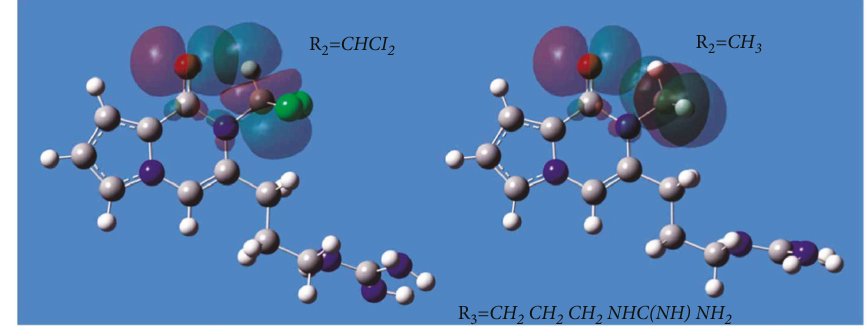
Figure 3: NBO overlap interaction surface plot for the bay region of pyrrolopyrazinones 22 (R stabilizing donor-acceptor n